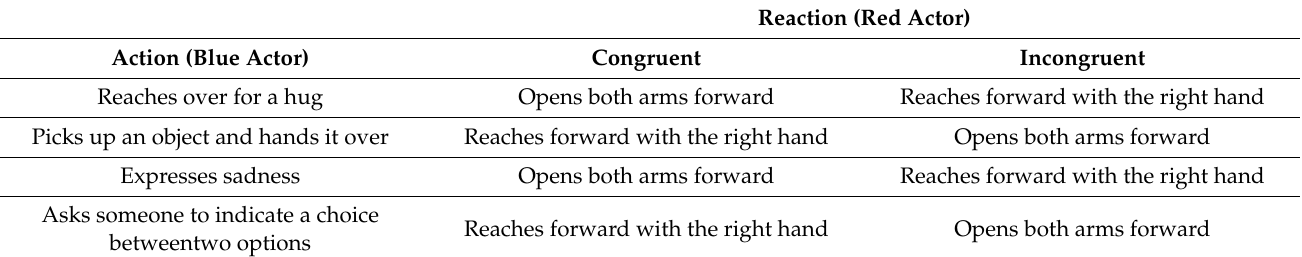
Table A2. Action–reaction sequences in Block